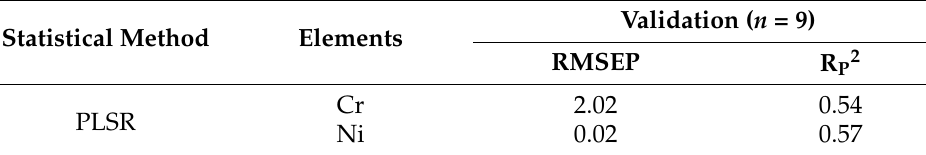
Table 8. Validation of the models for prediction of soil Cr, and Ni concentrations based on